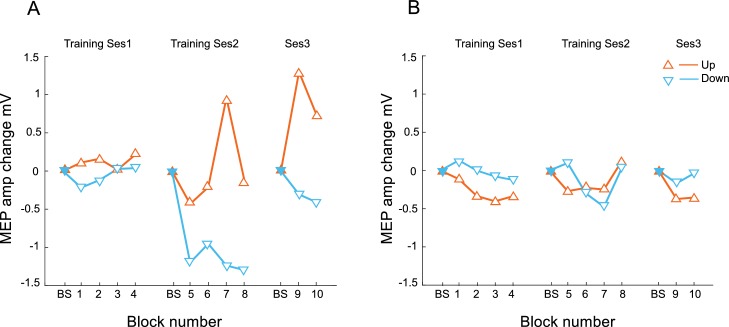
Individual representative subjects’ performance across trials.Change in MEP amplitude from baseline is shown (in mV) for one representative subject from the experimental group (panel A) and control group (panel B) for each neurofeedback training block in each session. Each triangle represents the mean of 30 MEP trials, with the baseline (resting) mean subtracted in order to demonstrate the magnitude of learning related changes across sessions. Orange triangles represent UP blocks and blue represent DOWN blocks.